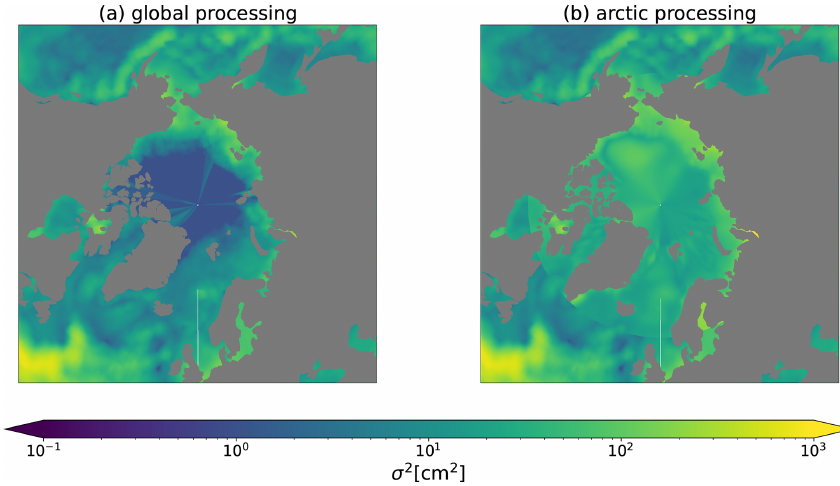
Figure 4. A priori signal variance maps used in (a) DUACS global processing and (b) the Arctic regional